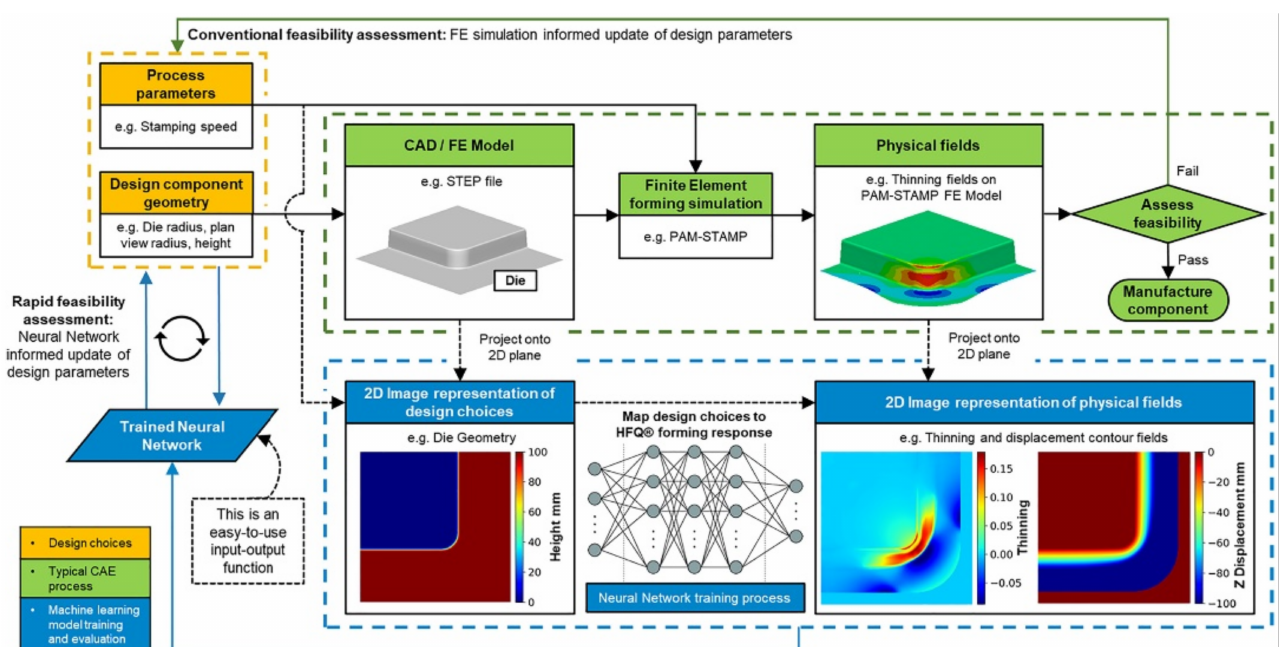
Figure 2. Process optimization of HFQ based on the CNN-based surrogate